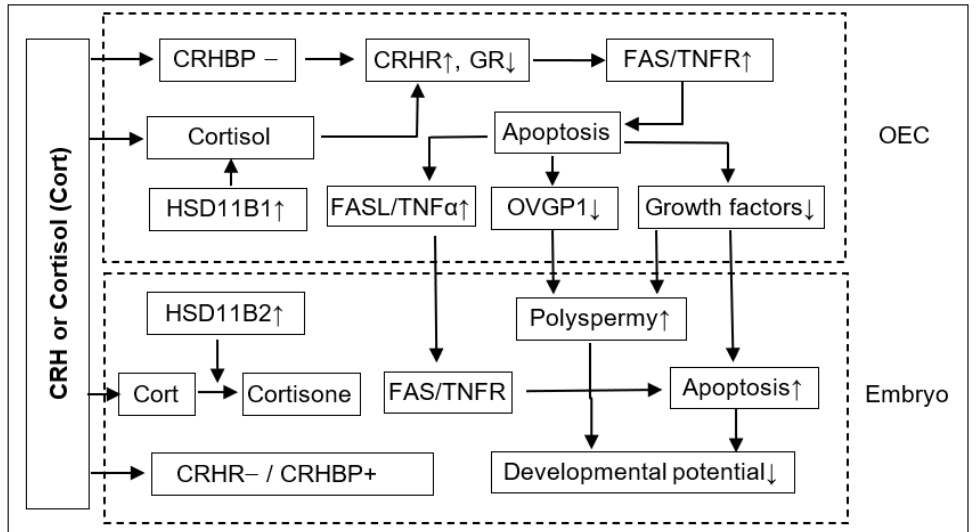
Figure 8. Possible pathways by which corticotrophin-releasing hormone (CRH) or cortisol (Cort) impairs preimplantation development of pig embryos. Please refer to the last paragraph of the Dis- cussion for detailed explanations for the figure. “ − ”: Not expressed; “+”: Expressed; “ ↑ ”: Increased; “ ↓ ”: Decreased.